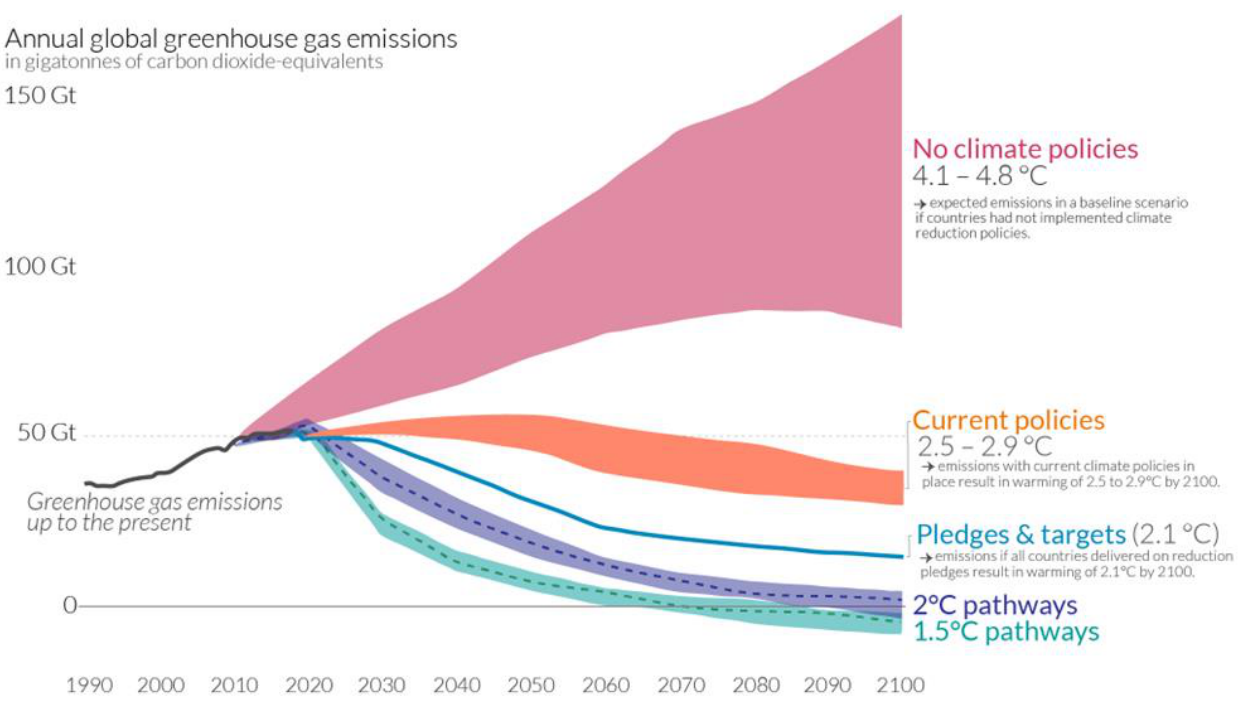
Figure 1. Global GHGE and warming scenarios, reproduced with authorization from [8].